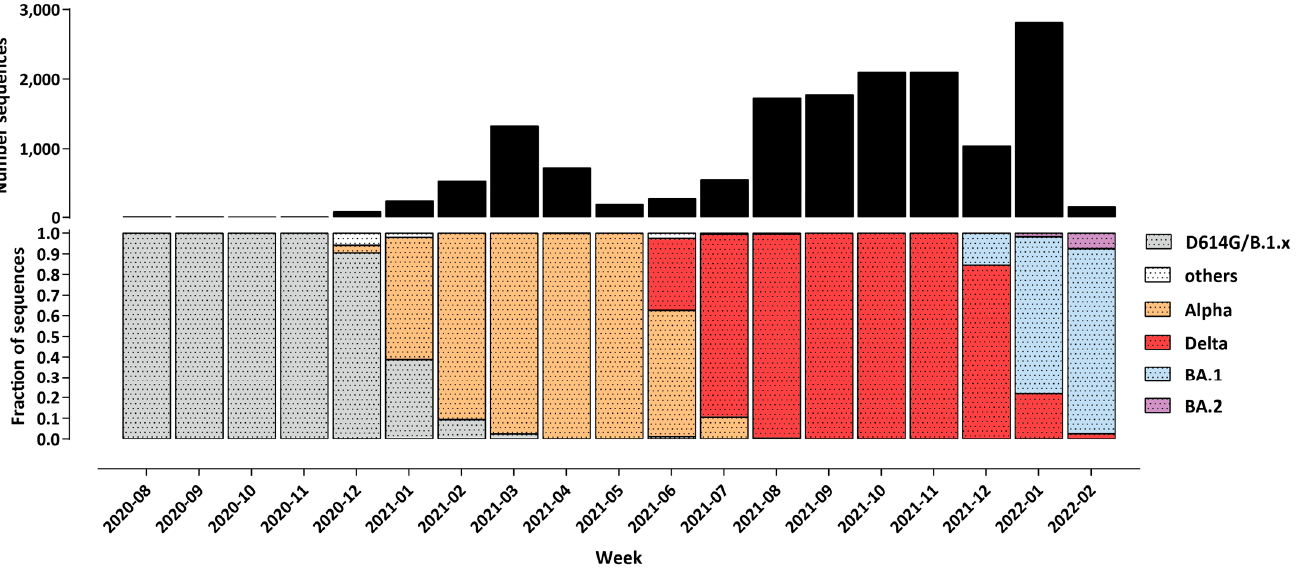
Figure 2. Evolution of the SARS-CoV-2 variant composition in the course of the COVID-19 epi- demic in Bulgaria up to March 2022 . Shown is the fraction of sequenced genomes belonging to each of the listed variants for each month, since the beginning of December 2020. The total number of sequenced SARS-CoV-2 genomes is shown on top.